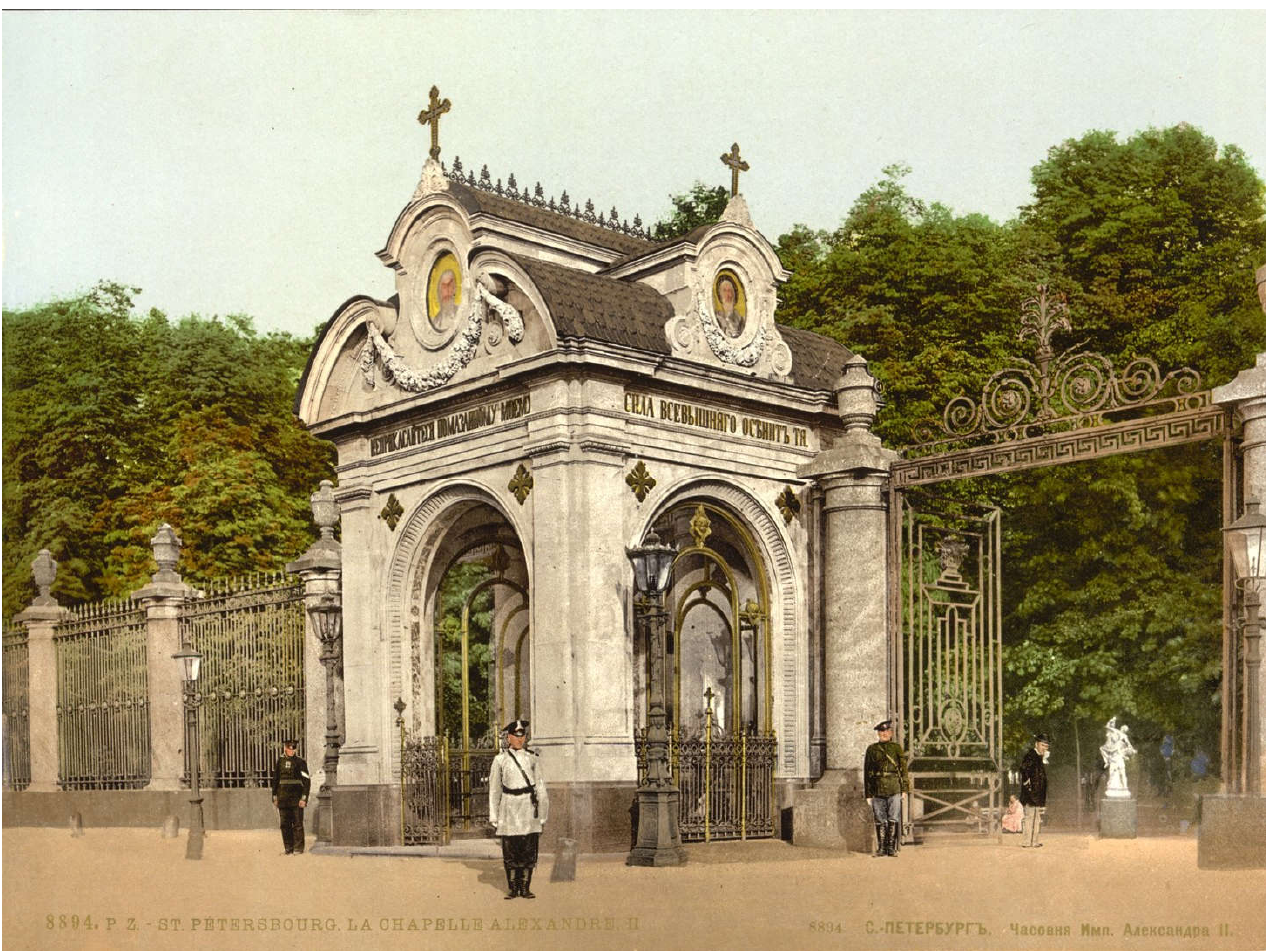
Figure 2. The chapel on the site of the 4 April 1866 assassination attempt in St. Petersburg’s Summer Garden (destroyed in 1930).